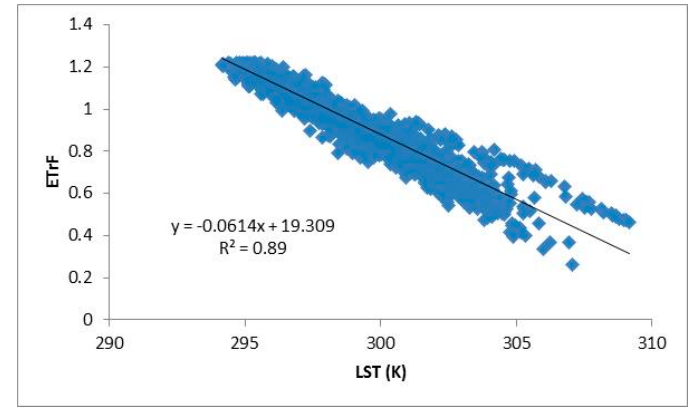
Figure 4. LST map (K) (17 July 2006).